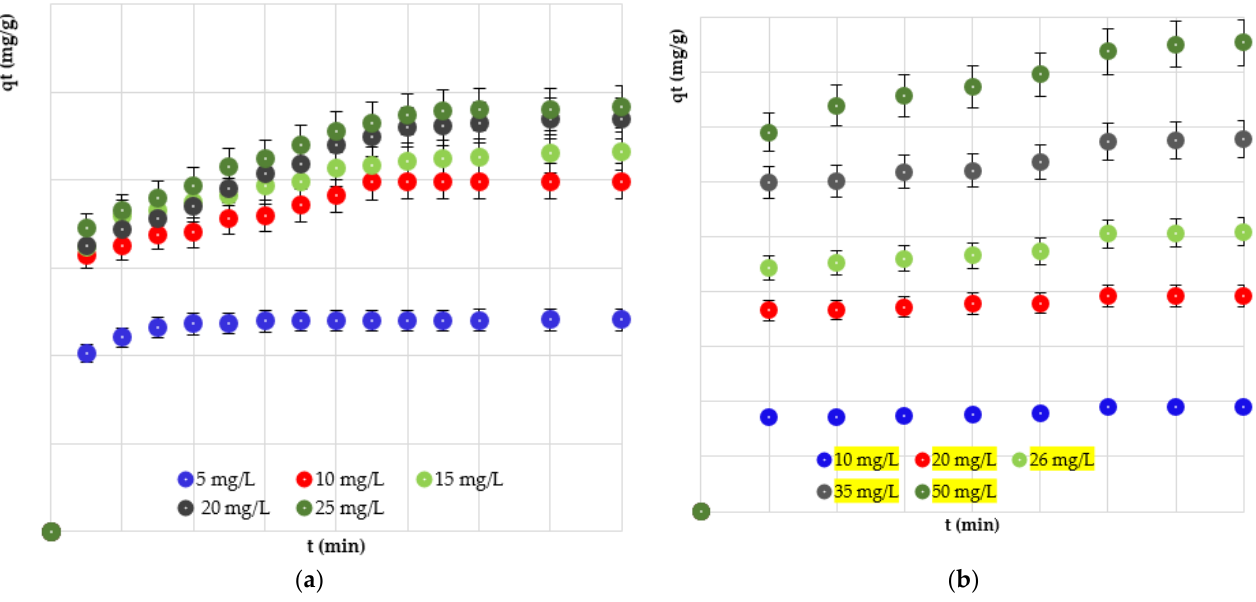
Figure 3. Effect of contact time and initial concentration of dyes: ( a ) MB; ( b ) MG on the adsorption capacity of 4AZW (S/L = 1 g/L, T = 25 ± 1 ◦ C and unadjusted pH). The qe values of both MB and MG sharply increased from 10 min to 50 min